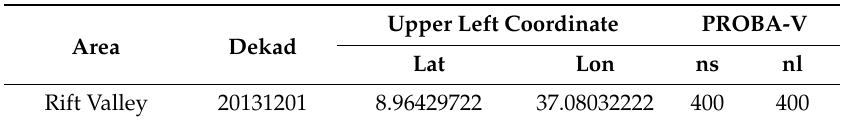
Table A1. The Ethiopian Rift Valley test area used for fixed threshold definition, the upper left corner coordinate and number of samples (ns) and lines (nl) are given.